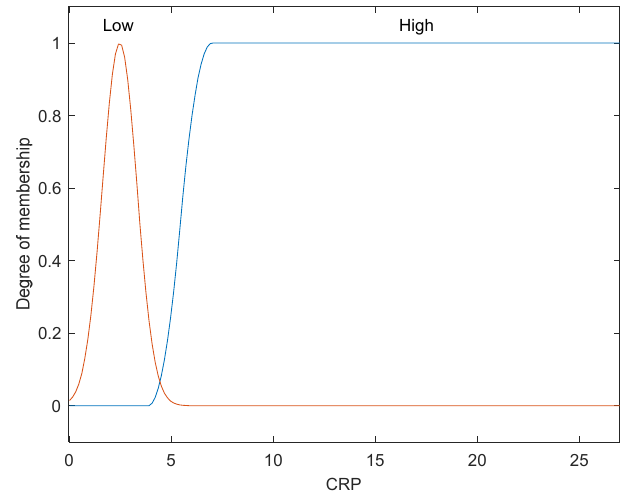
Figure 3. Membership function of Hb as input variable.